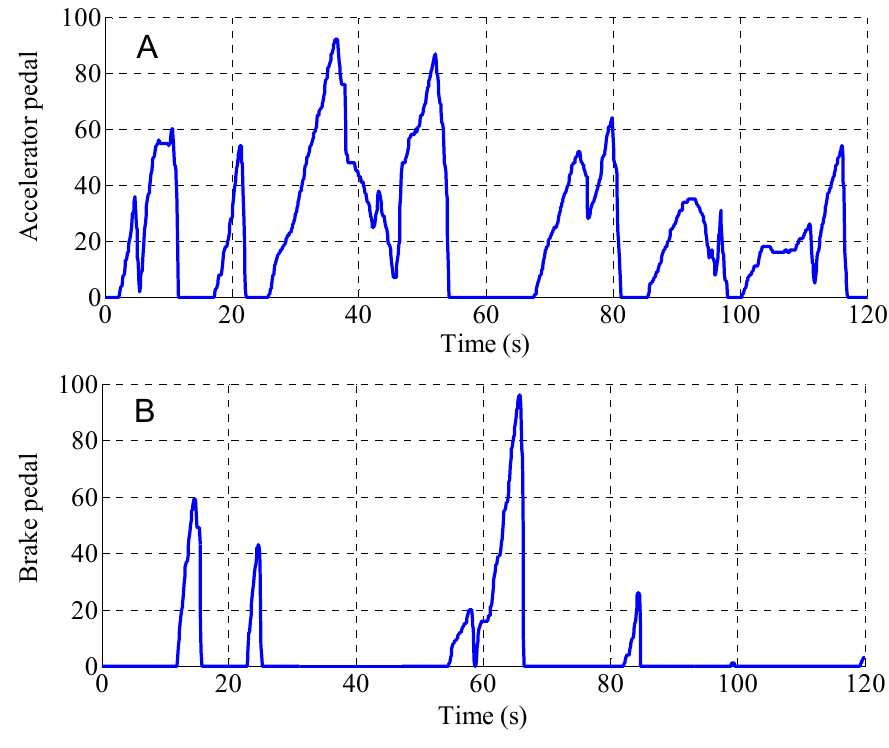
Figure 9. Driver operation signals: ( A ) Acceleration pedal; ( B ) Brake